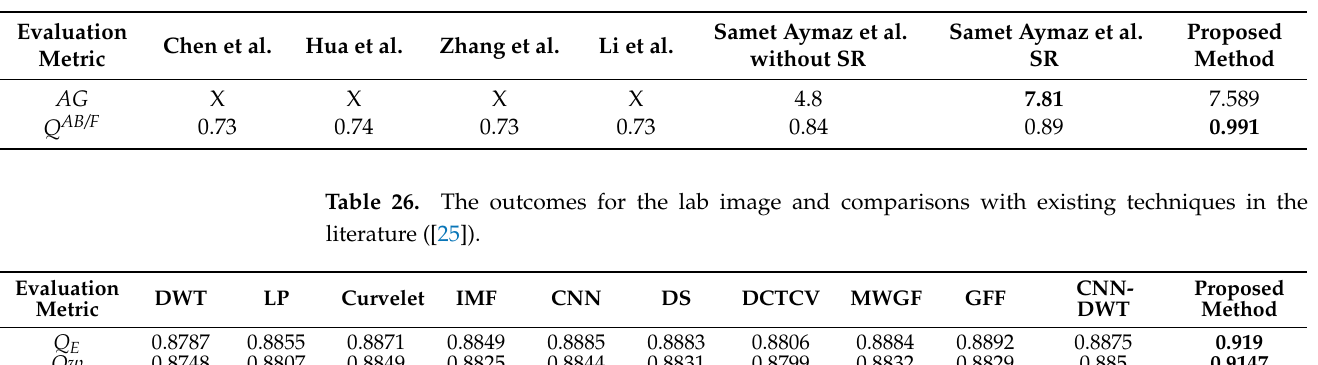
Table 25. The outcomes for the lab image and comparisons with existing techniques in the literature ([24]).